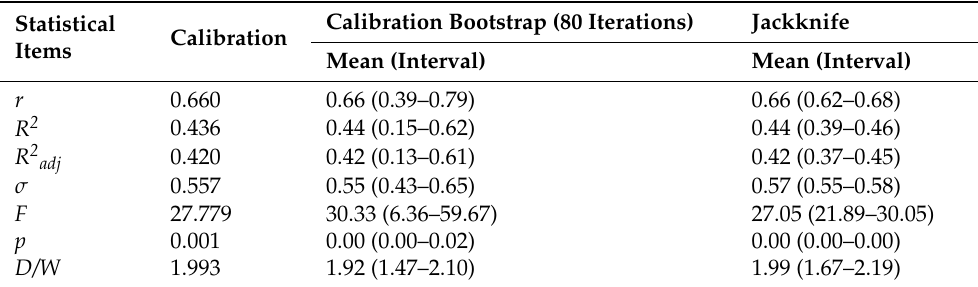
Table 4. Verification results of the Bootstrap and Jackknife methods.